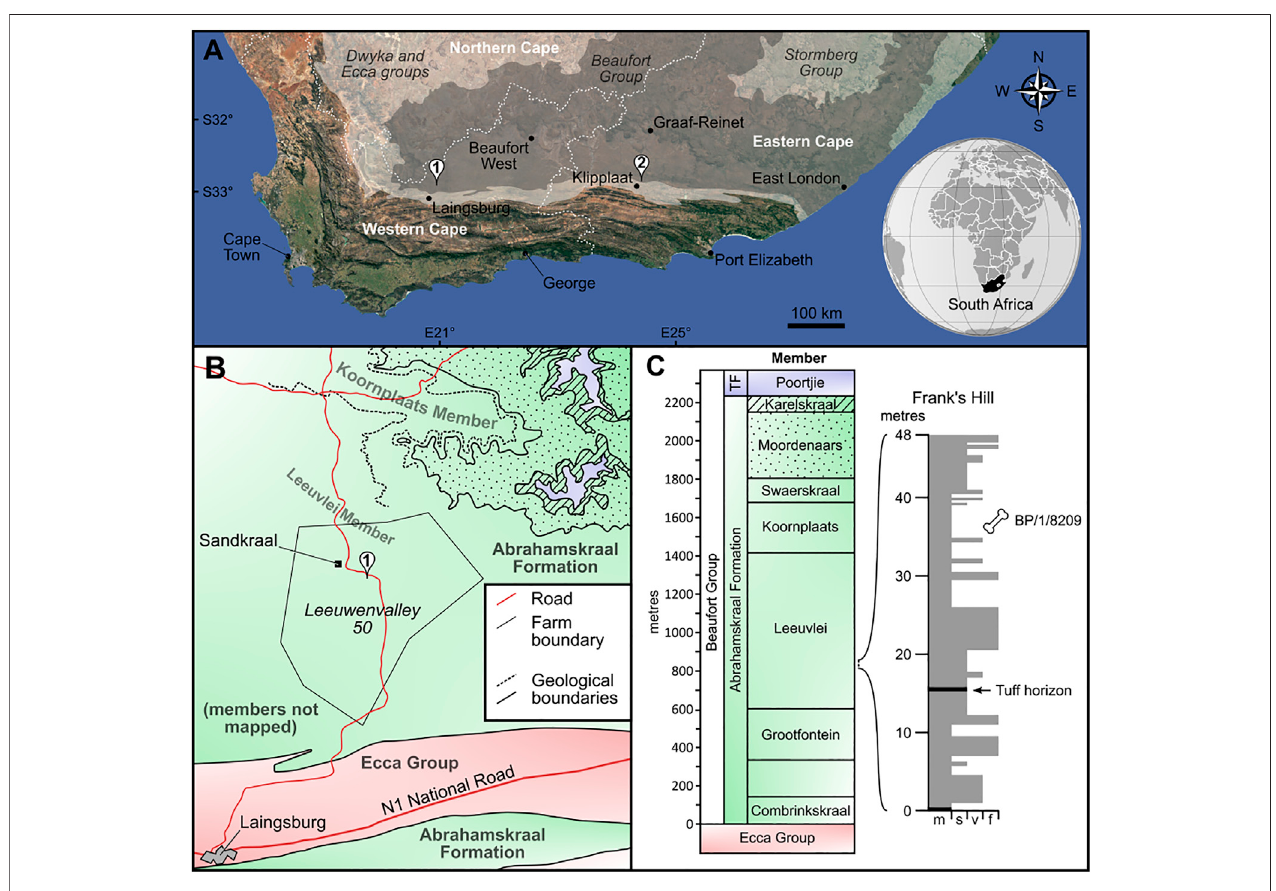
FIGURE 1 | Locality and stratigraphic information for Lanthanostegus . (A) Map showing the localities of BP/1/8209 (1) and of the type specimens of Lanthanostegus (2) within the Karoo Basin of South Africa. (B) Geological map of the southern Moordenaarskaroo showing the locality of BP/1/8209 at “ Frank ’ s Hill ” on Sandkraal (1). The only members of the Abrahamskraal Formation to have been mapped throughout the area are the Karelskraal and Moordenaars members; lower members of this formation have been mapped in a limited area north from Sandkraal (dashed lines) by Loock et al. (1994). (C) Stratigraphic divisions and thicknessesoftheAbrahamskraalFormationintheMoordenaarskaroo(fromDayandRubidge,2014)andstratigraphicsectionfrom “ Frank ’ sHill ” showingthepositionof BP/1/8209 and a tuffaceous horizon. TF, Teekloof Formation; f, fi ne sandstone; m, mudrocks; s, siltstone; v, very fi ne sandstone. Images modi fi ed from Google Earth and Wikimedia Commons